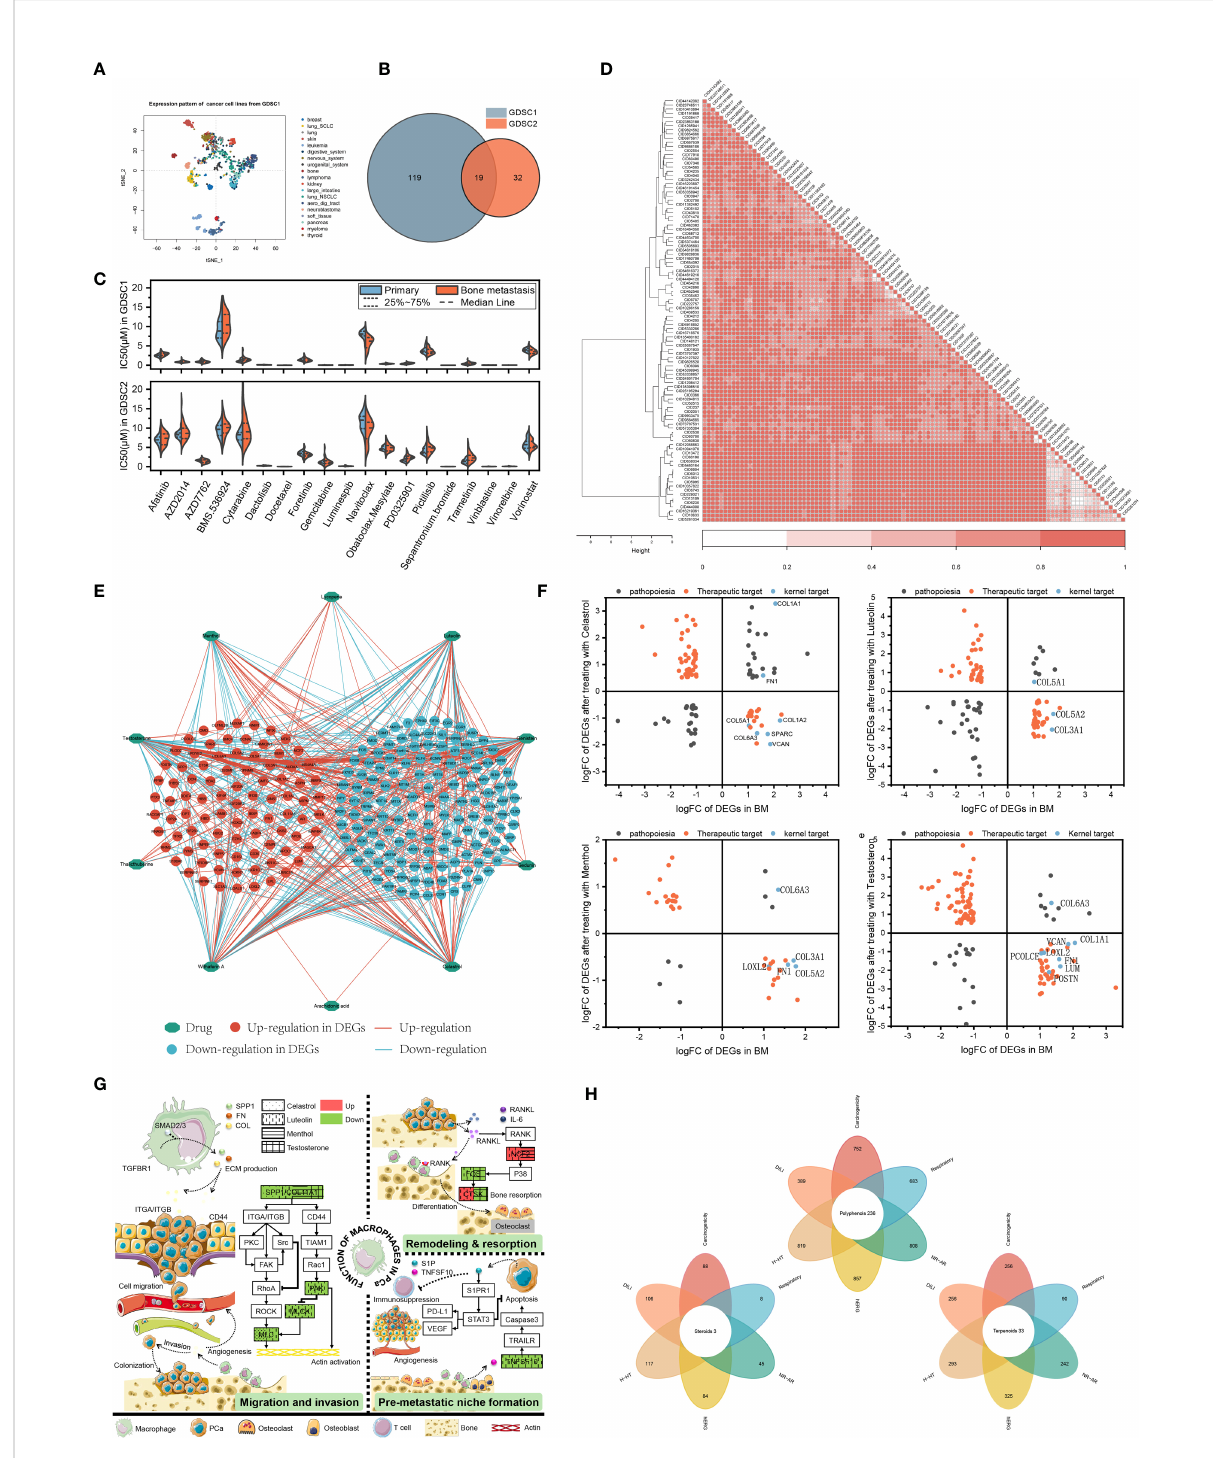
FIGURE 3 Integrating transcriptomes and network-based drug repurposing. (A) Cellular gene expression signature. (B) Sensitive drugs with co-occurrence in GDSC1&2. (C) IC50 of drugs in primary focus and BMs. (D) Structure-based drug cluster analysis. (E) Network pharmacology of natural compounds. (F) Topology-based candidate natural compounds. (G) Pathway patterns of candidate natural compounds. (H) Rational structure compounds in the MedChemExpress